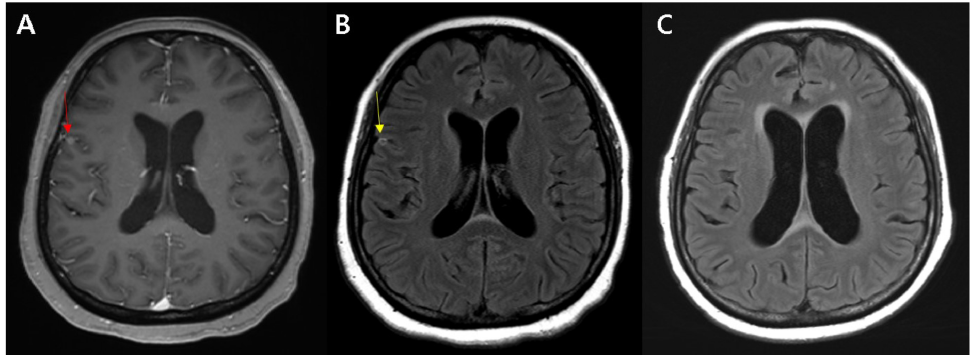
Figure 4. Rim enhancement superficial to the metastatic brain tumors. A 55-year-old female presented with headache showed focal homogeneously enhancing mass at right precentral gyrus, unknown cause (red arrow, ( A )). Peripheral rim enhancement around the mass is observed on postcontrast FLAIR (yellow arrow, ( B )), which means the cortical lesion is a mass rather than an infarction. The patient was diagnosed with lung cancer through further examination, including bronchoscopic lung biopsy, and we concluded that the enhancing lesions were metastasis from lung cancer. Subsequently, she received whole brain radiotherapy, and was started on treatment with combination chemotherapy. Follow up MRI after 3 months shows complete tumor disappearance ( C ).